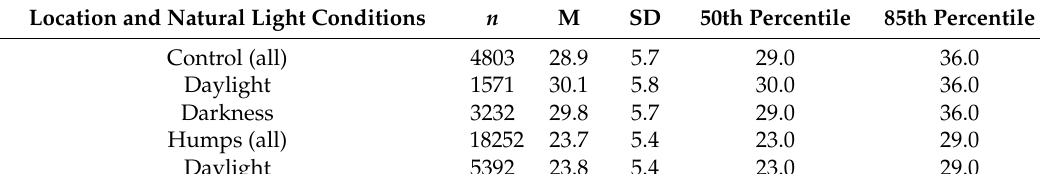
Table 1. Descriptive statistics on the speed (km/h) of free-flowing vehicles at the control location and at humps, divided by natural light conditions (daylight/darkness). n = number of vehicles, M = mean value, SD = standard deviation. 50th and 85th percentile speeds are also shown.